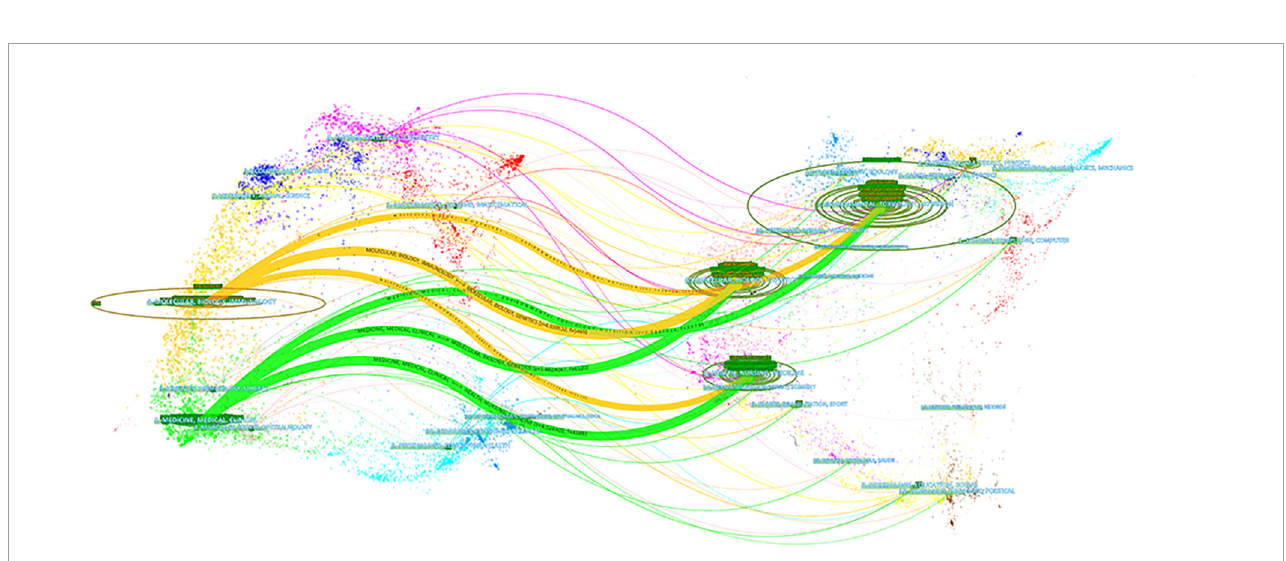
FIGURE5 A dual-map overlap of journals of Mediterranean diet (MD) on cancer. The left is the cited journal and the right is the cited journal, the longer transverse diameter of the ellipse represents more publications in the corresponding journal.